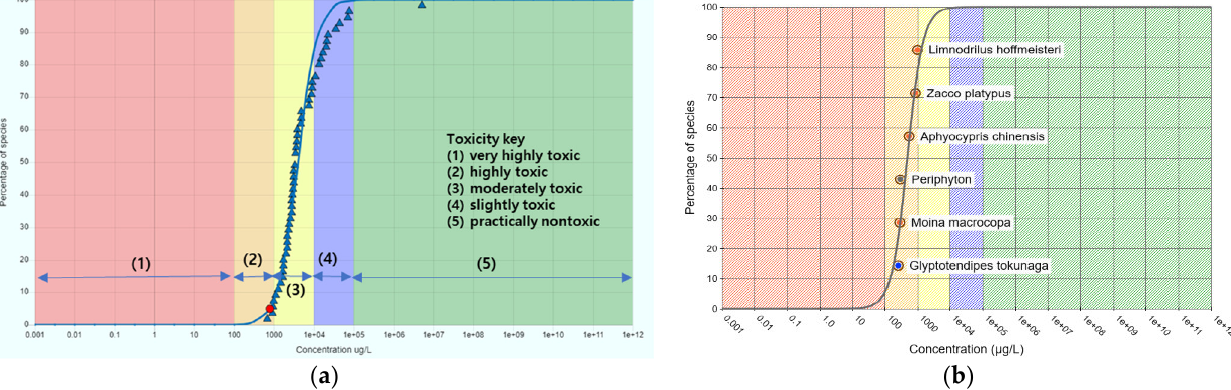
Figure 6. Species sensitivity distribution (SSD) curves with toxicity data. ( a ) SSD (ICE modeling data) and ( b ) SSD (mesocosm study data).